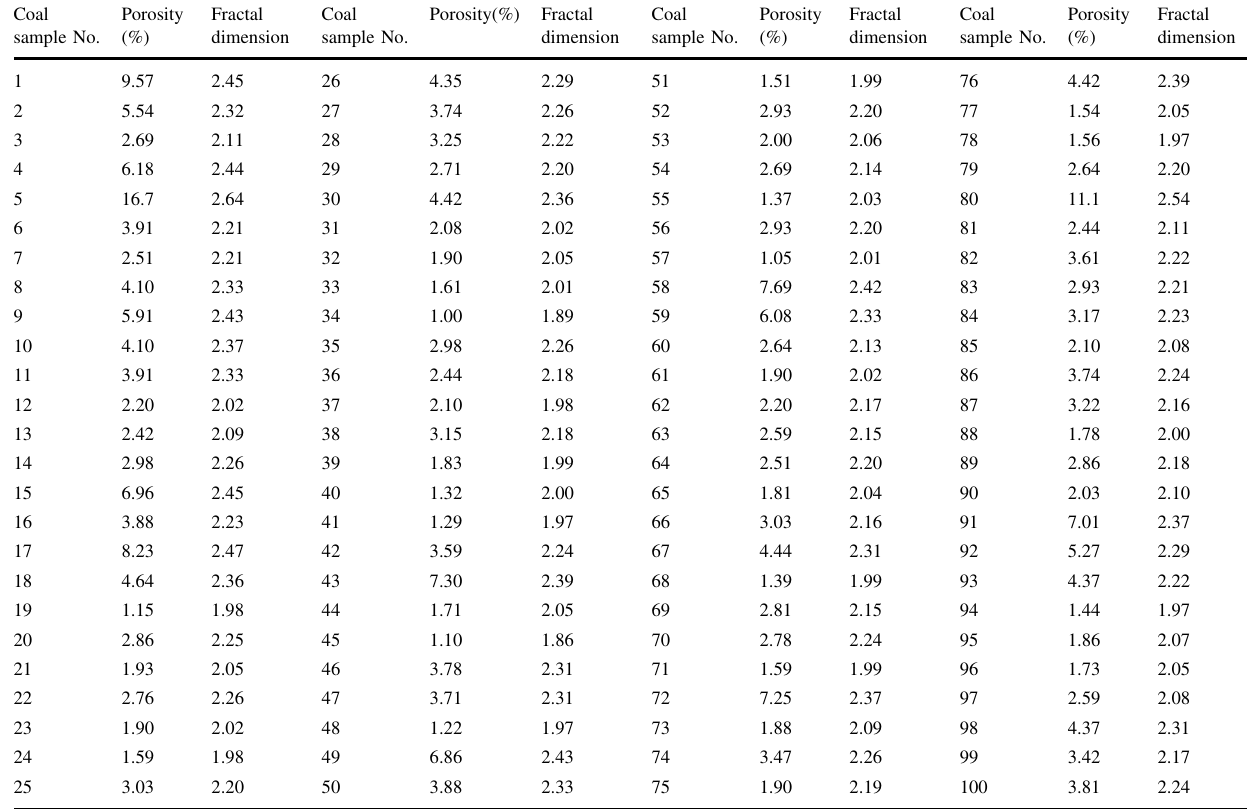
Table 1 Calculated porosity and fractal dimension values of coal sample SH-8 Coal Porosity Fractal sample No. (%)